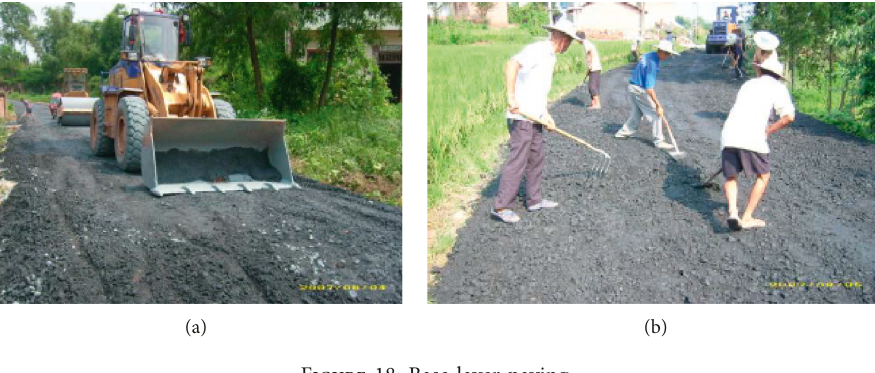
Figure 18: Base layer paving.